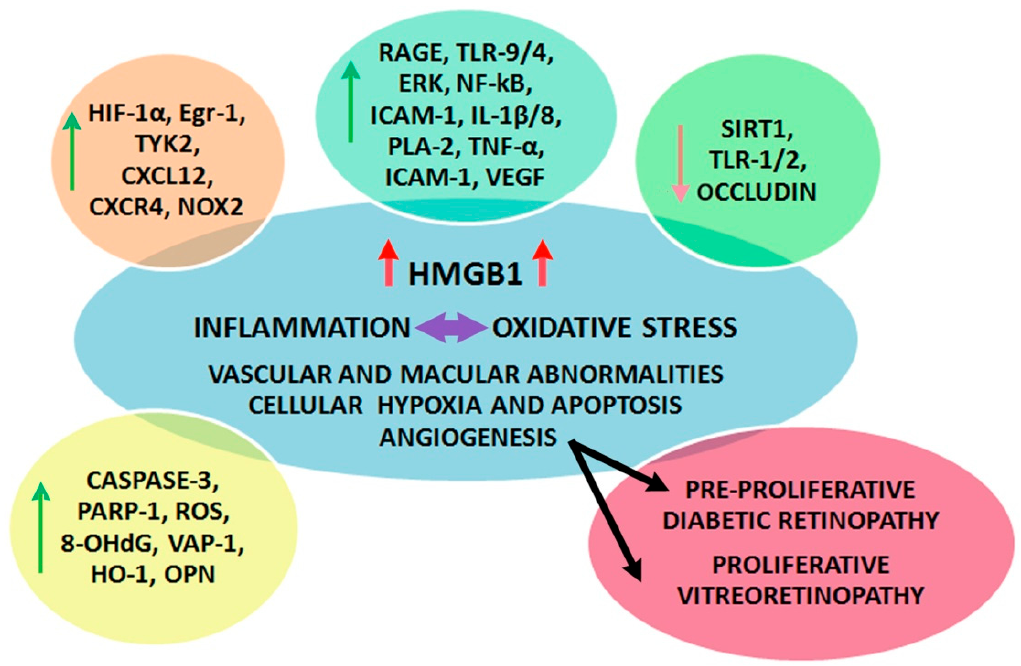
Scheme 2. High-mobility group box 1 (HMGB1) levels increased in diabetic retinopathy (DR). HMGB1 promotes angiogenesis directly and indirectly. Multiple functions of HMGB1 in DR are limited to murine models and in vitro studies. HIF-1 α : hypoxia induced factor-1 α ; Egr-1: early growth response protein 1; TYK2: tyrosine kinase 2; CXCL12 / CXCR4: chemokine; NOX2: nicotinamide adenine dinucleotide phosphate oxidase; RAGE: receptors for advanced glycation end-products; TLR-1 / 2 / 9 / 4: toll like receptor-1 / 2 / 9 / 4; ERK: extracellular signal-regulated kinase; NF-kB: nuclear factor- κ B; ICAM-1: intercellular adhesion molecule-1; IL-1 β / 8: interleukin-1 β / 8; PLA-2: phospholipases A2; TNF- α : tumor necrosis factor- α ; VEGF: vascular endothelial growth factor; SIRT1: sirtuin; PARP-1: poly ADP-ribose polymerase; ROS: reactive oxygen species; 8-OHdG: 8-hydroxydeoxyguanosine; VAP-1: vascular adhesion protein-1; HO-1: heme oxygenase-1; OPN: